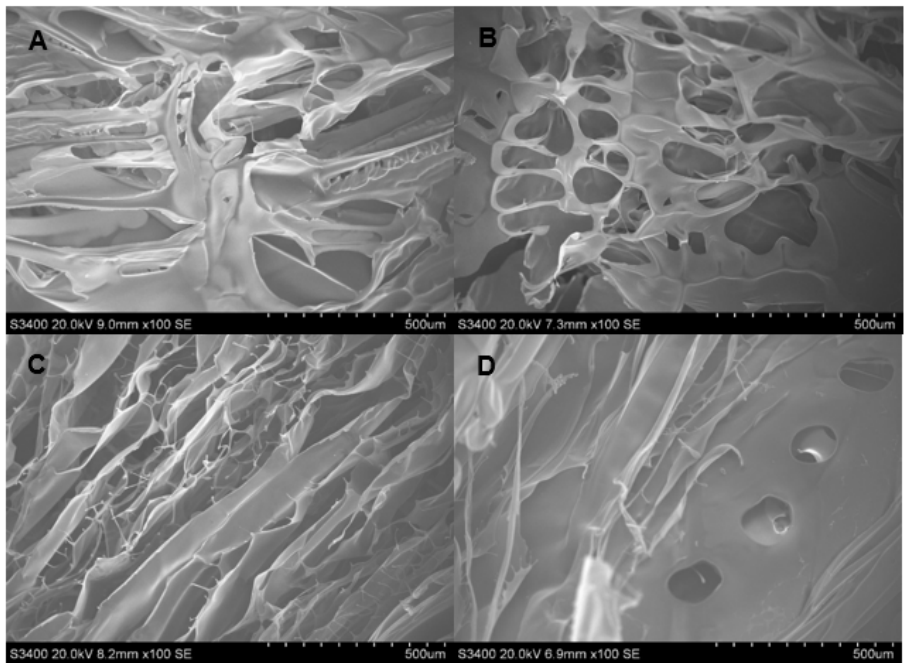
Figure 2. SEM images of hydrogel porous scaffolds made from solution of ( A ) 9:1 gelatin/SCMC solution (100×); ( B ) 9:1 gelatin/SCMC solution and 2% glutaraldehyde (100×); ( C ) 9:1 gelatin/SCMC solution and DOX (100×) and ( D ) 9:1 gelatin/SCMC solution, DOX, and 2% glutaraldehyde (100×).